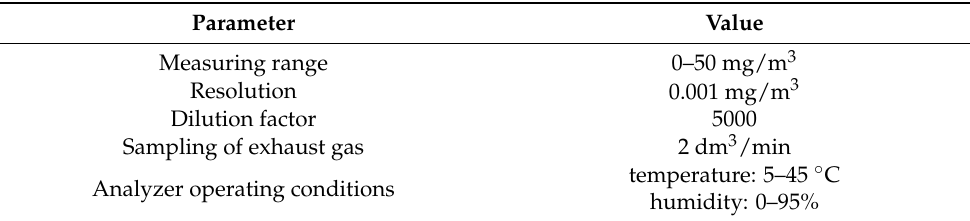
Table 4. Specifications of the AVL 483 MSS particulate analyser.